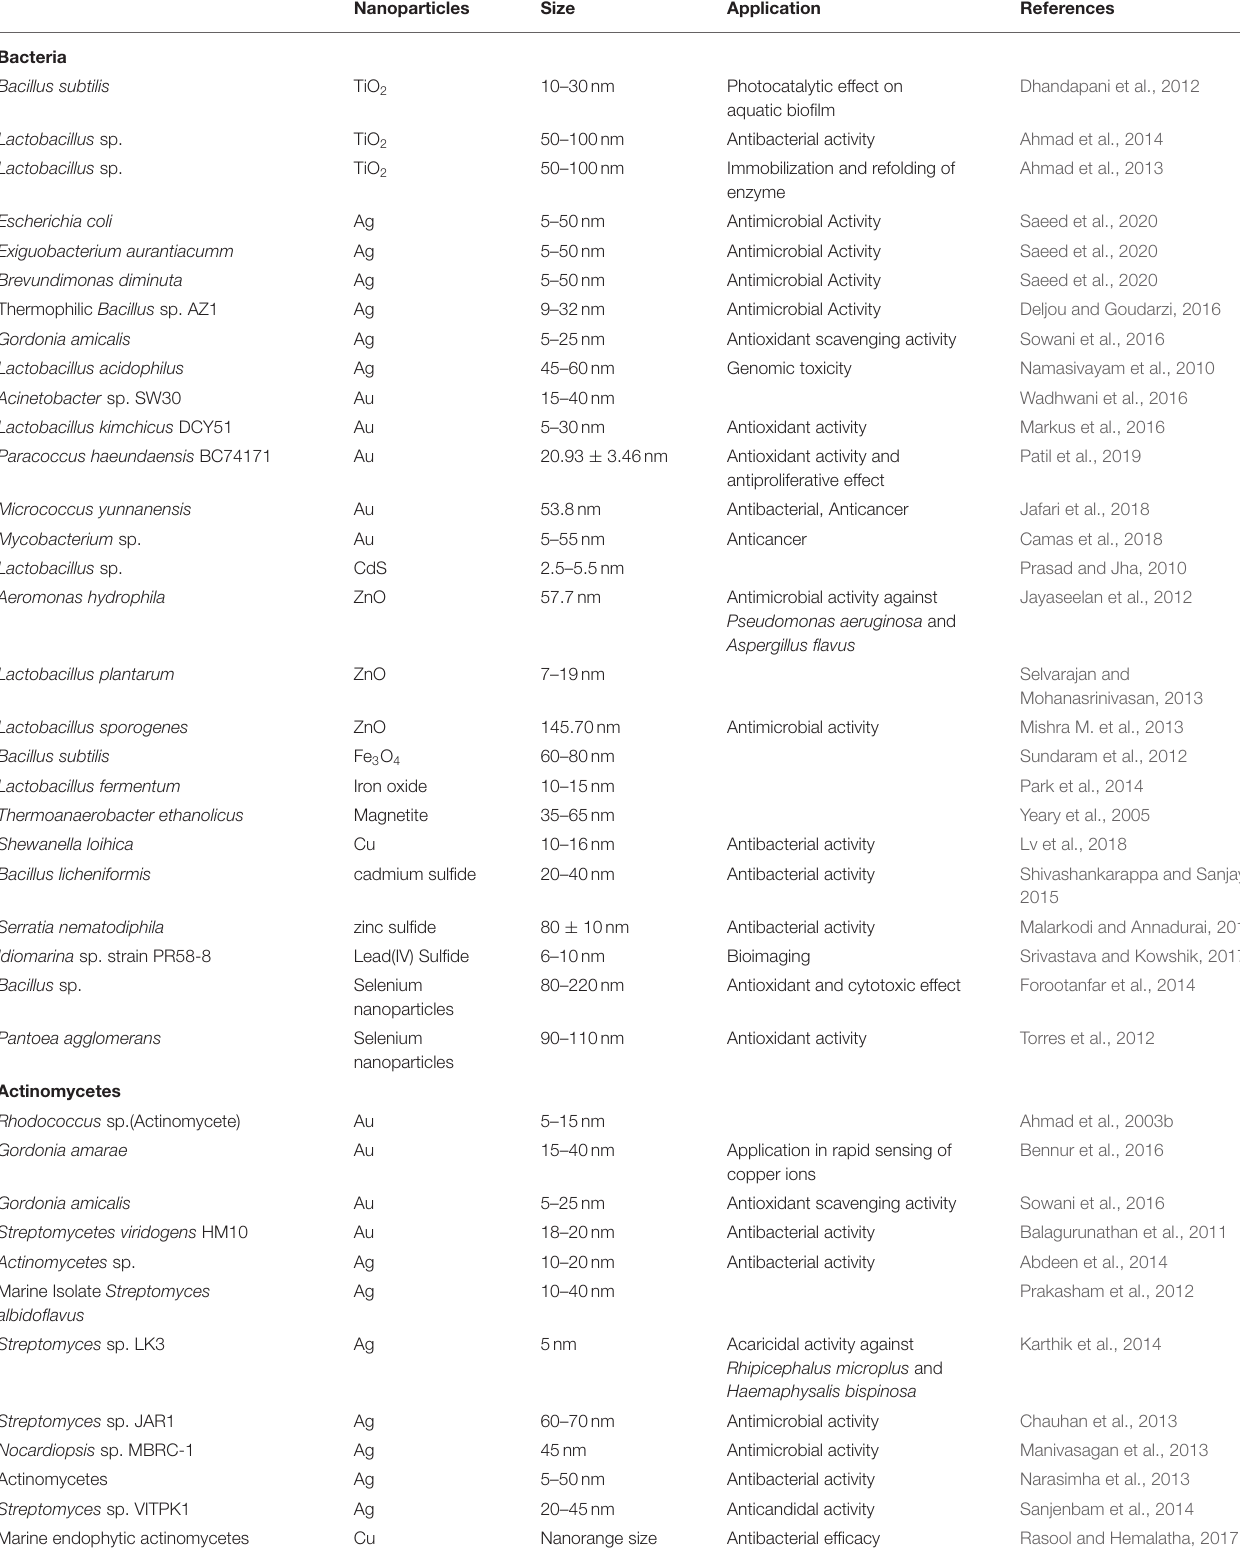
TABLE 1 | Microbial mediated synthesis of